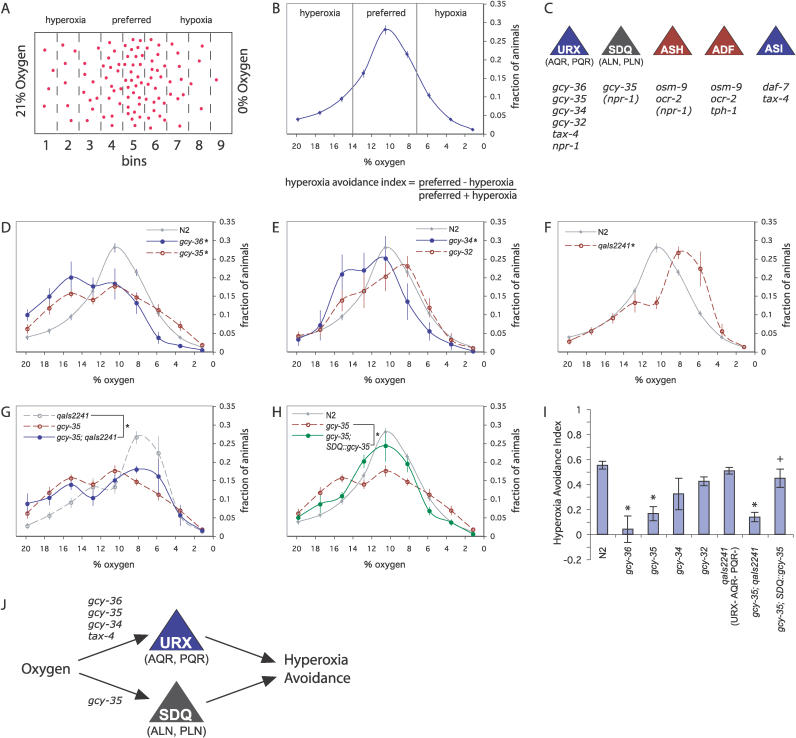
Two Distinct Groups of sGC-Expressing Neurons Promote Hyperoxia Avoidance(A) A cartoon of the typical distribution of 100 wild-type N2 animals (red dots) in a 0%–21% oxygen gradient. Adult animals are placed on an agar surface under a 3-cm × 1.5-cm PDMS chamber; laminar flow of gases at either end of the chamber generates an oxygen gradient within the chamber. The positions of animals are scored after 25 min. For counting, animals are binned in nine equally spaced regions along the device.(B) In a 0%–21% oxygen gradient, wild-type N2 animals avoid both hyperoxia (14%–21% O2) and hypoxia (0%–7% O2), preferring the center of the gradient (7%–14% O2) (n = 28 assays, 80–100 animals/assay).(C) Neurons (top row) and genes that appear in this study. npr-1 is expressed in SDQ and ASH, but not known to affect their function [13].(D–E) Aerotaxis of gcy-35 and gcy-36 mutants (D) and gcy-32 and gcy-34 mutants (E).(F) Aerotaxis of qaIs2241 animals, which bear a transgene that kills the URX, AQR, and PQR neurons.(G) Aerotaxis of gcy-35; qaIs2241 mutants.(H) Aerotaxis of gcy-35 mutants in which SDQ, ALN, and PLN were rescued with a lad-2::gcy-35 transgene.In (D–H), asterisks denote distributions different by chi-square analysis at p < 0.01 from the first distribution in the panel, unless otherwise noted. n ≥ 3 assays per genotype, 80–100 animals/assay. Error bars are standard error of the mean (SEM). Aerotaxis assays in all figures follow a standard color code: red and blue colors are used for mutants, green is used for transgenic rescue strains, and gray is used for results repeated from an earlier figure.(I) The hyperoxia avoidance index is defined as [(fraction of animals in 7%–14% O2) − (fraction of animals in 14%–21% O2)] / (fraction of animals in 7%–21% O2). In (I), asterisks denote values different from N2 controls at p < 0.01 by Dunnett test. Cross, value different from the gcy-35 control at p < 0.05 by Bonferroni t test with N2 and gcy-35 controls. Error bars denote SEM.(J) Hyperoxia avoidance is promoted by two sets of sGC-expressing neurons: (1) some or all of URX, PQR, and PQR; and (2) some or all of SDQ, ALN, and PLN.